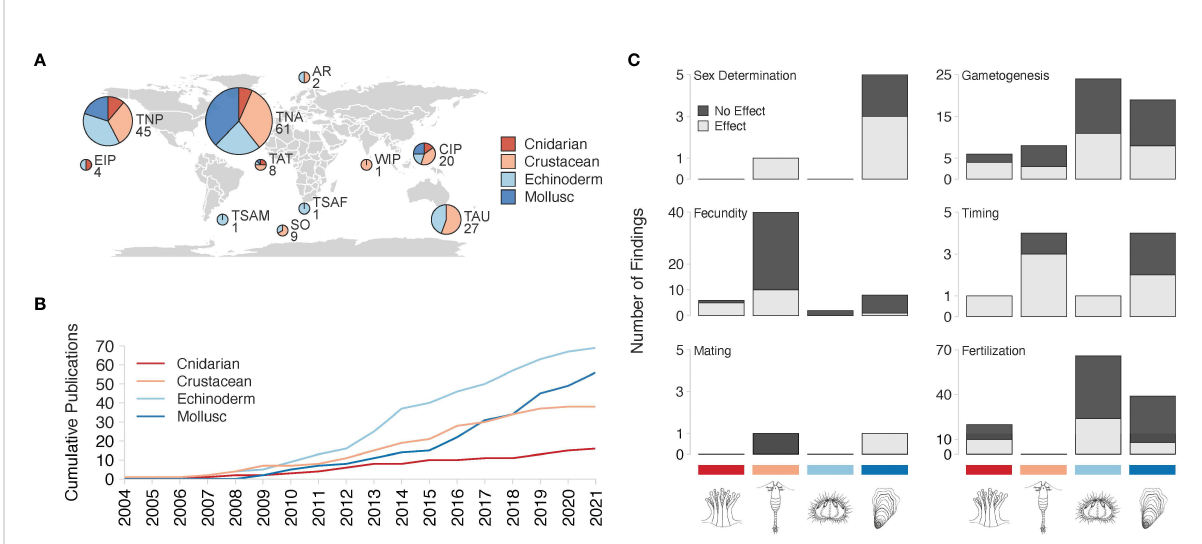
FIGURE 3 Summary of study locations, number of publications, and effects of Ocean Acidi fi cation on Reproductive Processes across taxa. (A) Graphical description of published studies used in this review. Pie charts for each geographic study locations are labeled with initials and the number of studies from that realm: Eastern Indo-Paci fi c (4), Temperate Northern Paci fi c (45), Temperate South America (1), Temperate Northern Atlantic (61), Tropical Atlantic (8), Southern Ocean (9), Temperate Southern Africa (1), Arctic (2), Western Indo-Paci fi c (1), Central Indo-Paci fi c (20), and Temperate Australasia (27). There were no studies from Tropical Eastern Paci fi c. Pie charts represent the proportion of taxa-speci fi c studies in which study organisms were collected in each region, and pie size and numbers underneath the pies represent the total number of studies in that region. Studies may be represented more than once in a pie chart if the study examined multiple taxa. (B) Cumulative number of papers published for each taxon from 2004 to 2021. One echinoderm study was published in 1924 but was not included in this fi gure. Studies may be represented more than once per year if the study examined multiple taxa. (C) Number of fi ndings that reported an OA effect (either positive or negative, light gray) or no effect (black) for various reproductive processes by taxa (from left to right: cnidarians, crustaceans, echinoderms,